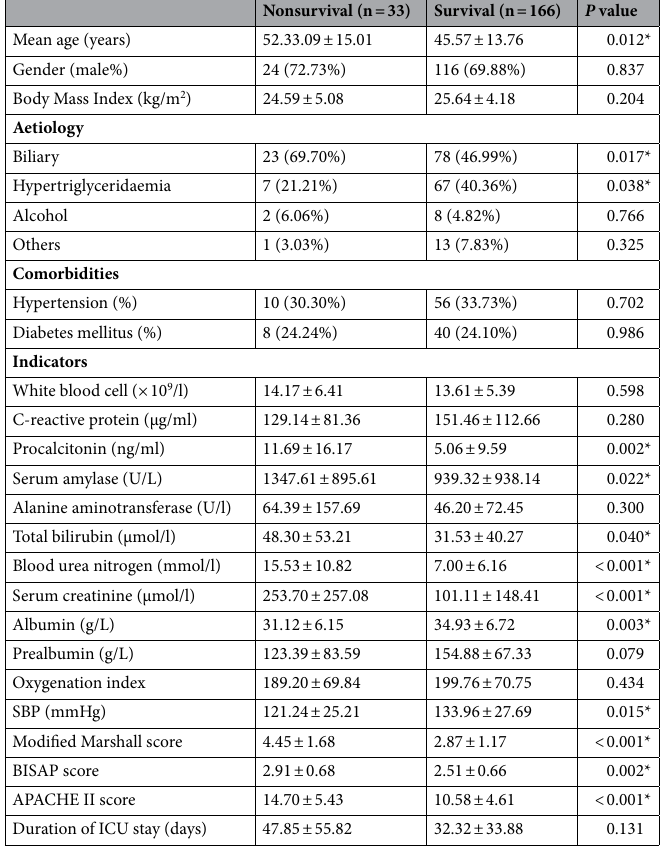
Table 1. Characteristics of patients with severe acute pancreatitis on admission (n%; x ±s). SBP